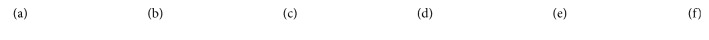
Effect of Rhus verniciflua extract (RVE) on the expression of COX-2 and p-cPLA2 genes in RBL-2H3 mast cells. (a) PGD2 levels in the culture medium of IgE-sensitized RBL-2H3 mast cells treated with RVE. (b, c) Immunoblot analysis performed with anti-COX-2 and p-cPLA2 antibodies. α-Tubulin was used as protein loading control. Results are expressed as mean ± SE of at least five independent experimental results that were tested by analysis of variance with Bonferroni's post hoc testing; #p < 0.05 versus the control group; ∗p < 0.05, ∗p < 0.005, and ∗∗∗p < 0.0005 versus the DNP-HSA-treated group.